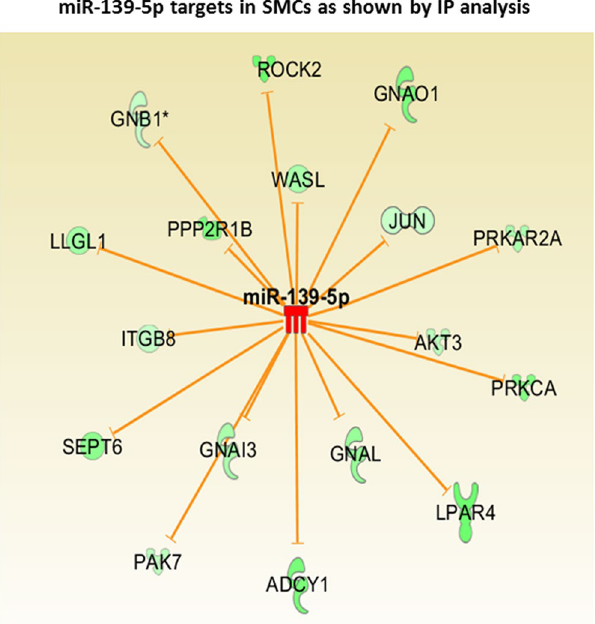
Figure 2. Ingenuity pathway analysis (IPA) showing ROCK2 as one of the direct targets of miRNA-139-5p. miRNA microarray data was subjected to ingenuity pathway analysis (IPA) and various validated targets of miR- 139-5p from the literature were plotted as an Interactome. The analysis shows that human ROCK2 is one of the direct targets of miR-139-5p as it has a direct miR-139-5p binding site at its 3 ′ UTR. Some of the other validated targets mentioned in literature, which may also be down-regulated in tonic smooth muscles are given in this